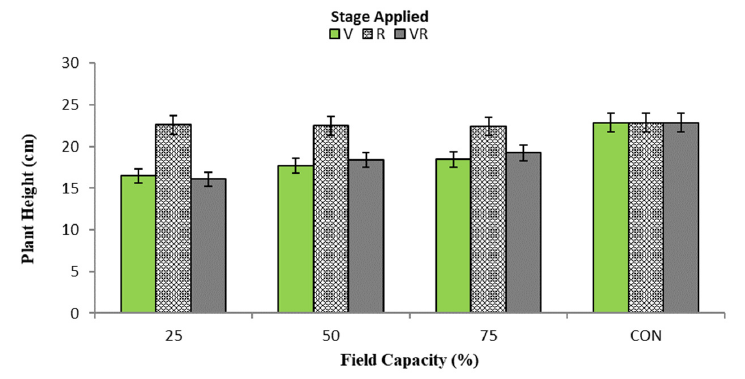
Figure 3. Effect of water deficit and treatment stage on plant height of okra at 4 weeks V (vegetative), R (reproductive), and VR (vegetative and reproductive) represent the stage at which the deficit was applied. Data in the interaction analysed with Least Squares Means, and means separated with LSD.